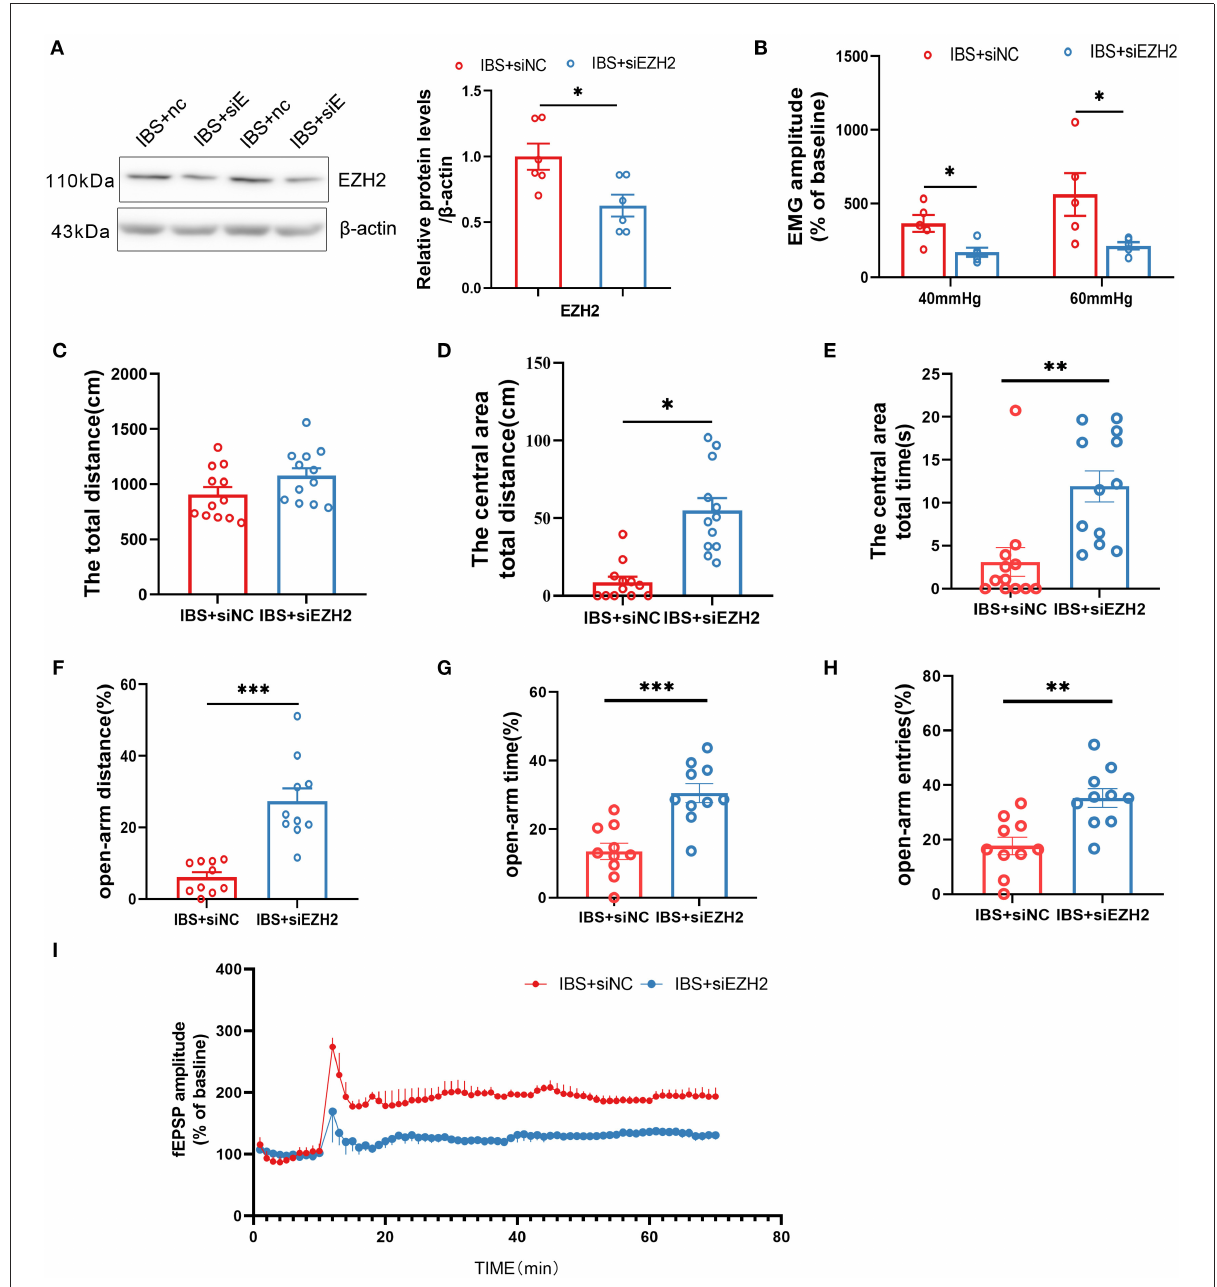
FIGURE7 Downregulation of CA1 EZH2 attenuates anxiety, visceral hypersensitivity and LTP in IBS-like rats. (A) EZH2 protein expression decreased after administration of siEZH2 into CA1 in IBS-like rats. N = 6, * p < 0.05. (B) The statistical chart of the percentage of EMG amplitude over baseline. N = 5, * p < 0.05. Statistical analysis of the total distance (C) , the distance (D) and time (E) in the central area of the OFT. N = 12, * p < 0.05, ** p < 0.01. Statistical analysis of the distance (F) , the time (G) , and the number of entries (H) in the open arm of EPM. N = 10, ** p < 0.01, *** p < 0.001. (I) Summary bar charts of field potential before and 60min after HFS in the slices of hippocampus. N = 3, * p < 0.05. EMG, electromyography; EPM, elevated plus maze test; HFS, High frequency stimulation; IBS, irritable bowel syndrome; OFT, open field test.